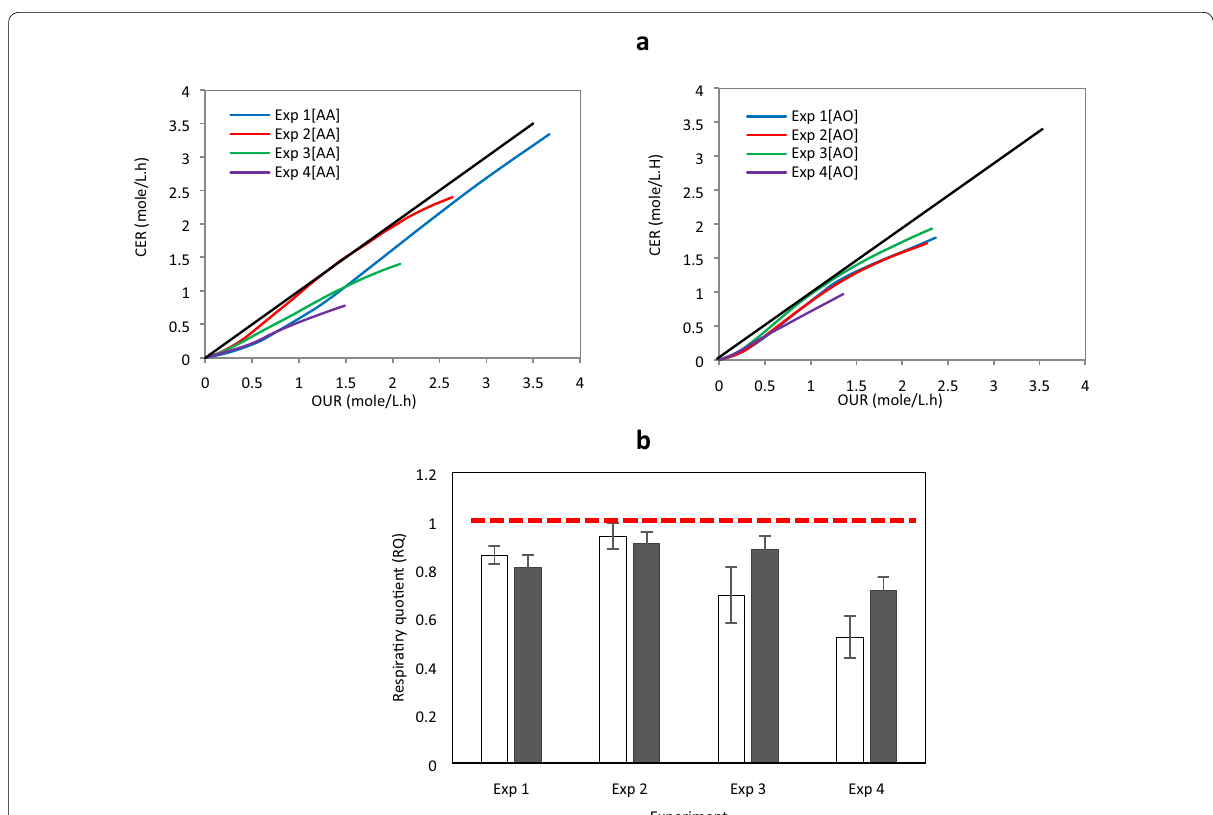
Fig. 5 a Profiles of RQ in multi-stacked tray SSB systems with the fungi A. awamori [AA] and A. oryzae [AO] with different initial moisture content arrangements. The black straight line represents RQ 1. b Respiratory quotient (RQ) during SSF of A. awamori (square) and A. oryzae (filled square) = on wheat bran using four tray SSBs with different initial moisture content arrangement. The red dash line represents RQ as mean standard deviation, and number of replications is three ( n ± =